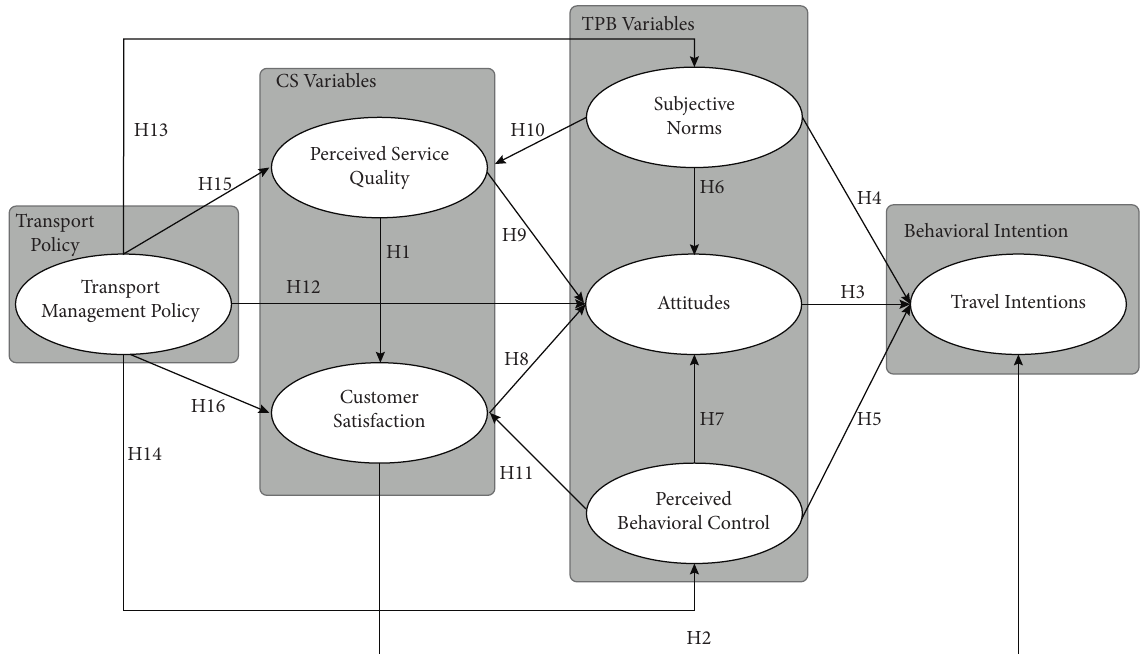
Figure 1: The proposed theoretical framework.